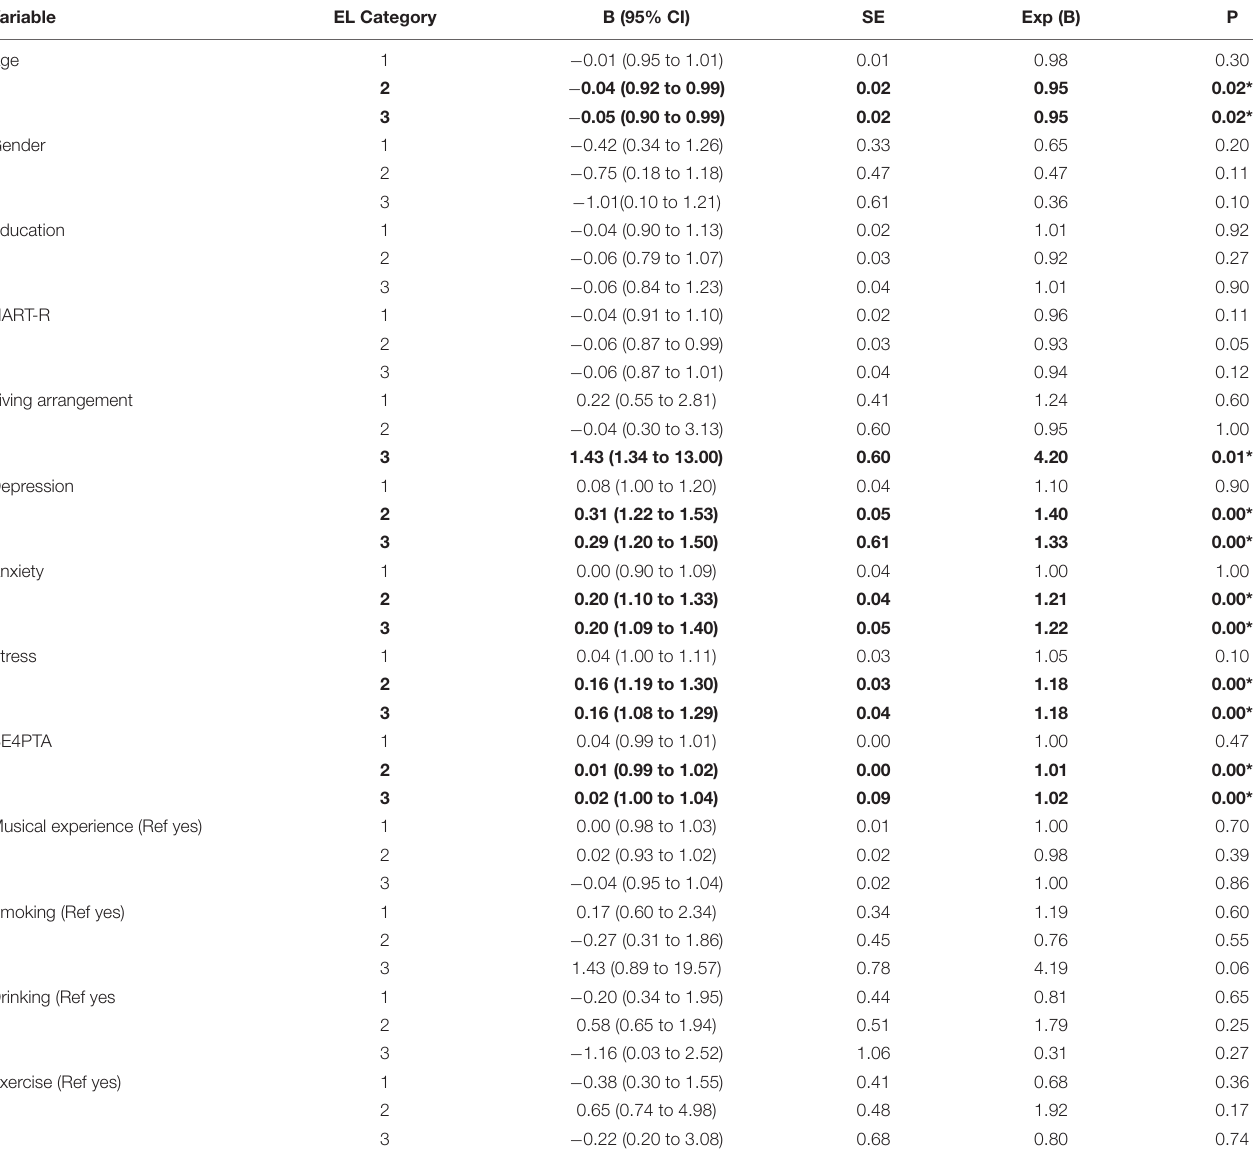
TABLE 6 | Association between Age, living arrangement, depression, anxiety, stress, and better ear 4PTA hearing thresholds on EL categories. Variable EL Category B (95%